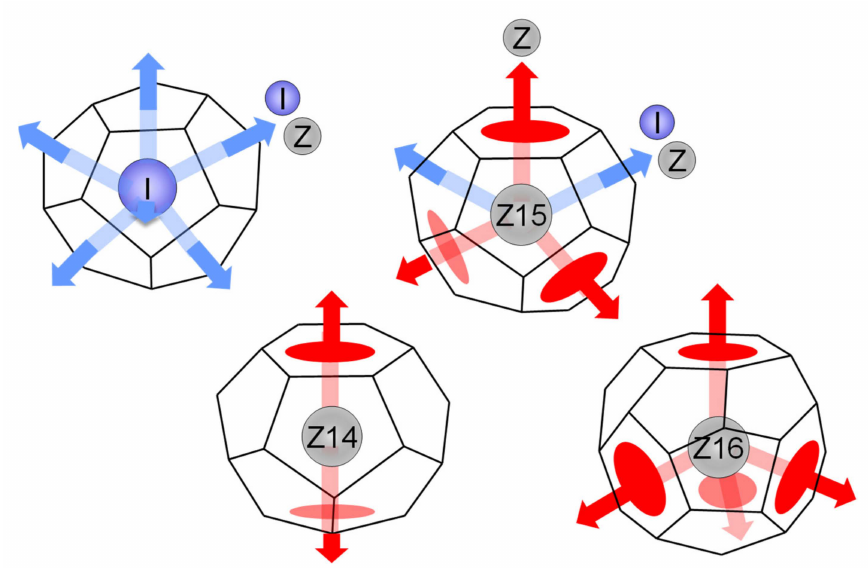
Figure 11. Schematics of the bicap-sharing connections between I- or Z-clusters through pentagonal faces (blue) and hexagonal faces (red).